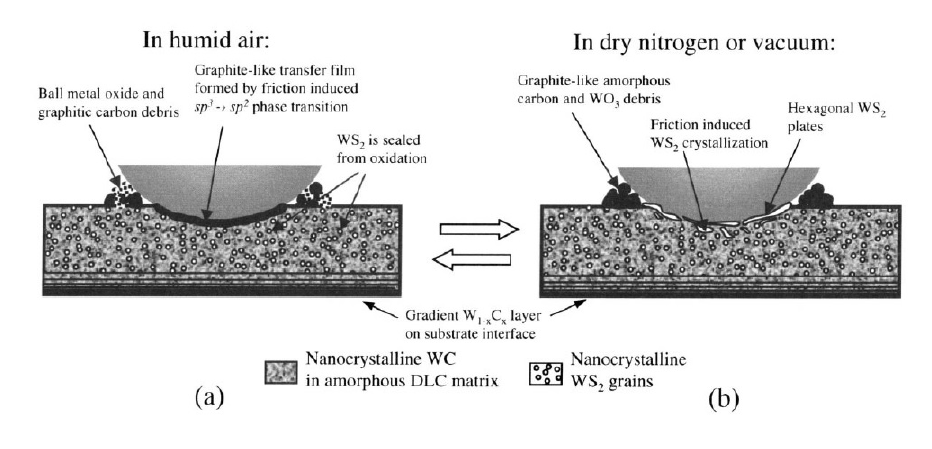
Figure 2. Principle of chameleon coating function [1].